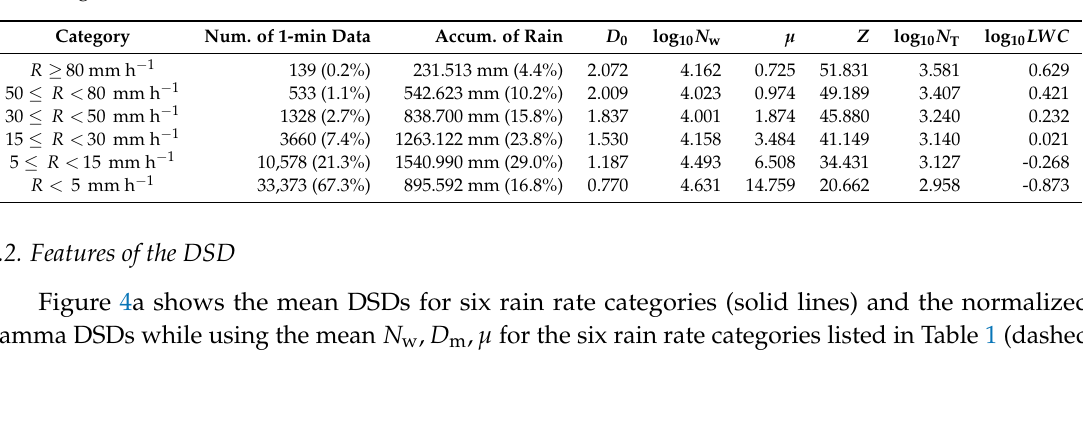
Figure 3. ( a ) The frequency of occurrence in daily rainfall, and ( b ) the accumulated rainfall fraction during May–October 2017. The gray bars in ( a ) indicate the periods of no data due to bad sensor status, and the gray bars in ( b ) indicate daily rainfall amount observed in the collocated raingauge. Note that the raingauge had stopped during 1–3 July. Table 1. Mean drop size distribution (DSD) parameters and integral rain parameters for six rain rate